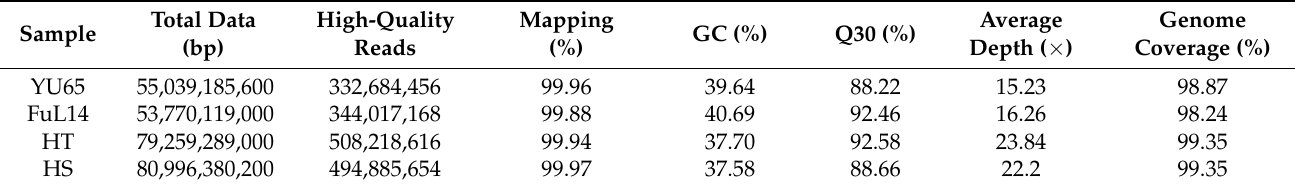
Table 2. Summary of Illumina sequencing of parental lines and bulks for LTG